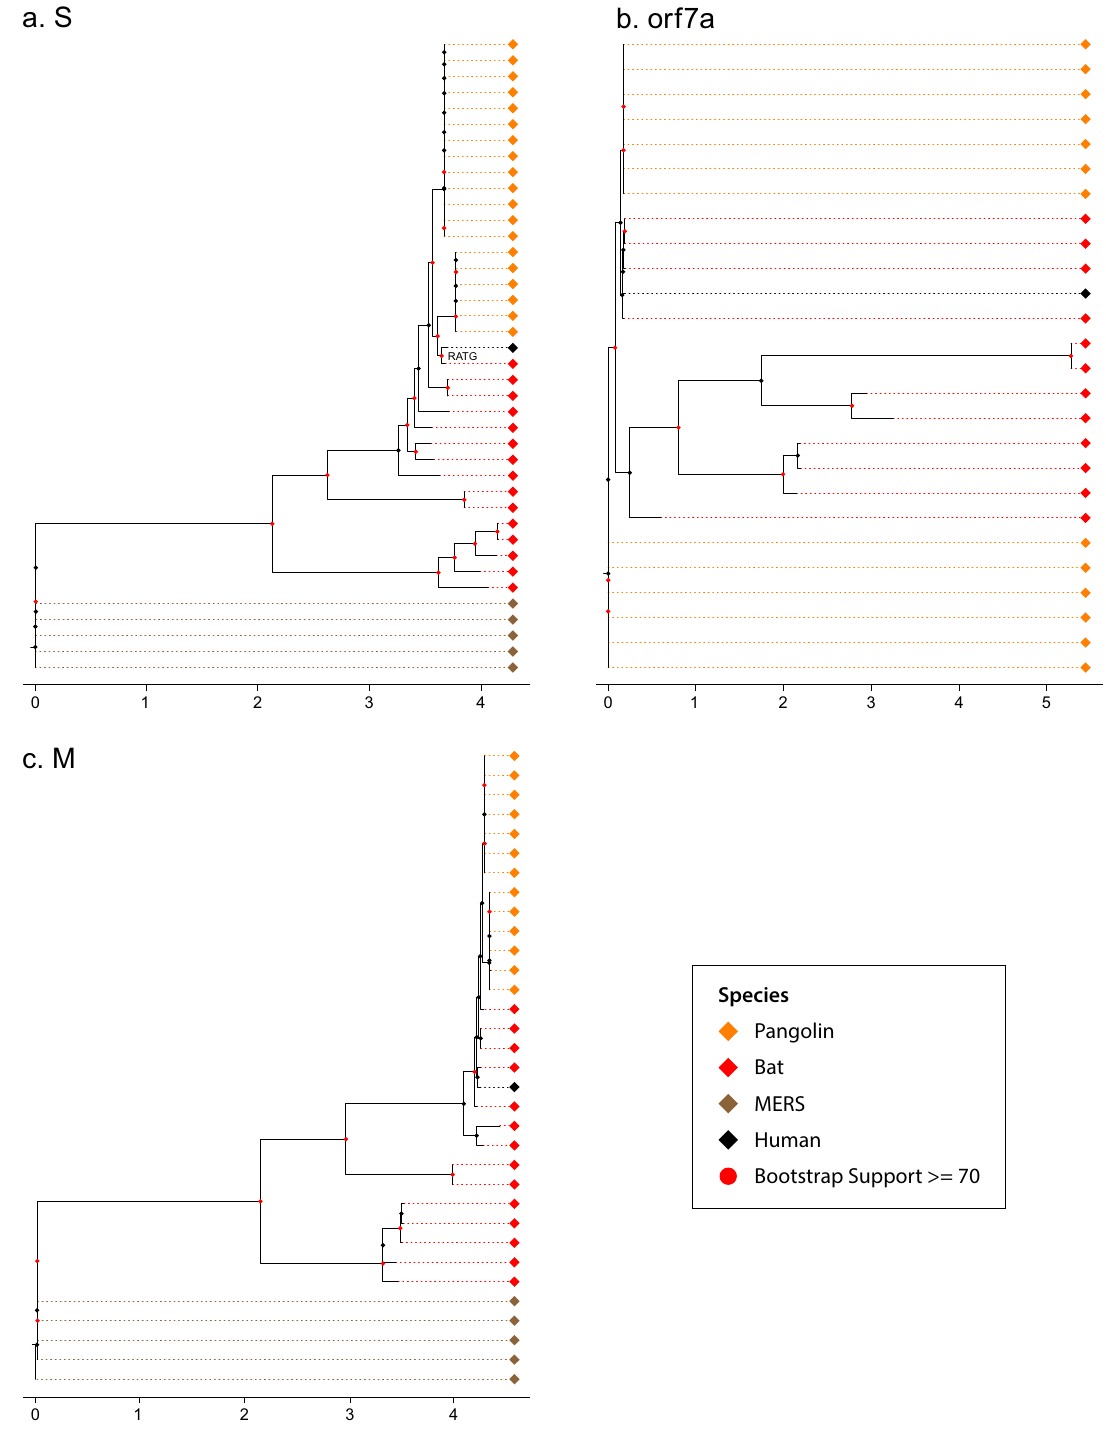
Figure 1. The consensus gene trees of the S, ORF 7a, and M genes are discordant: ( A ) S; ( B ) ORF 7a; ( C ) M. The gene trees were reconstructed by the method of maximum likelihood 19 from 5,248 viral genomes. The consensus gene trees were reconstructed from a bootstrap sample of 100 gene trees. Human, bat, pangolin, and MERS-CoV coronavirus sequences are color-coded as black, pink, orange, and dark orange, respectively. The MERS CoV genomes root the gene trees. All 11 gene trees for the coronavirus genome are in the supplement (Figs. S1–S11). The black diamond represents the amalgamation of human SARS-CoV-2 lineages. A common scale bar for tree branch lengths is provided. The branch lengths on Fig. 1 are the mean of the expected number of substitutions per site across all 100 gene trees in the bootstrap sample of each gene (see Materials and Methods). Red dots on the trees indicate nodes with at least 70% bootstrap